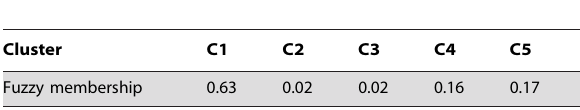
Table 5. Fuzzy membership values for the CLN3